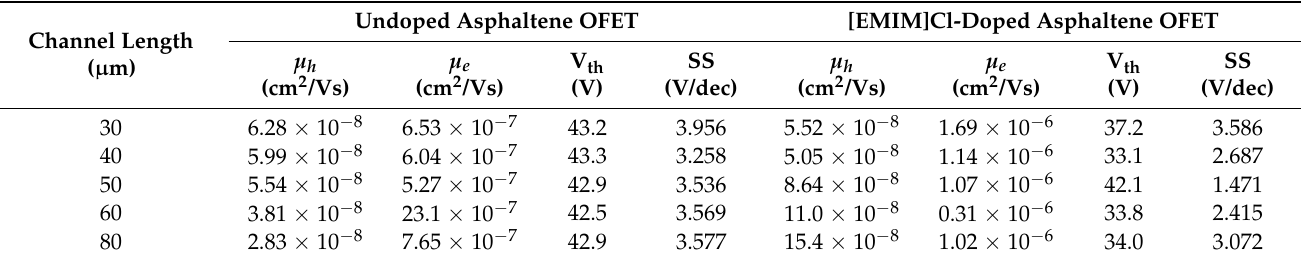
Table 5. Field-effect transistor characteristics of the undoped and [EMIM]Cl-doped asphaltene